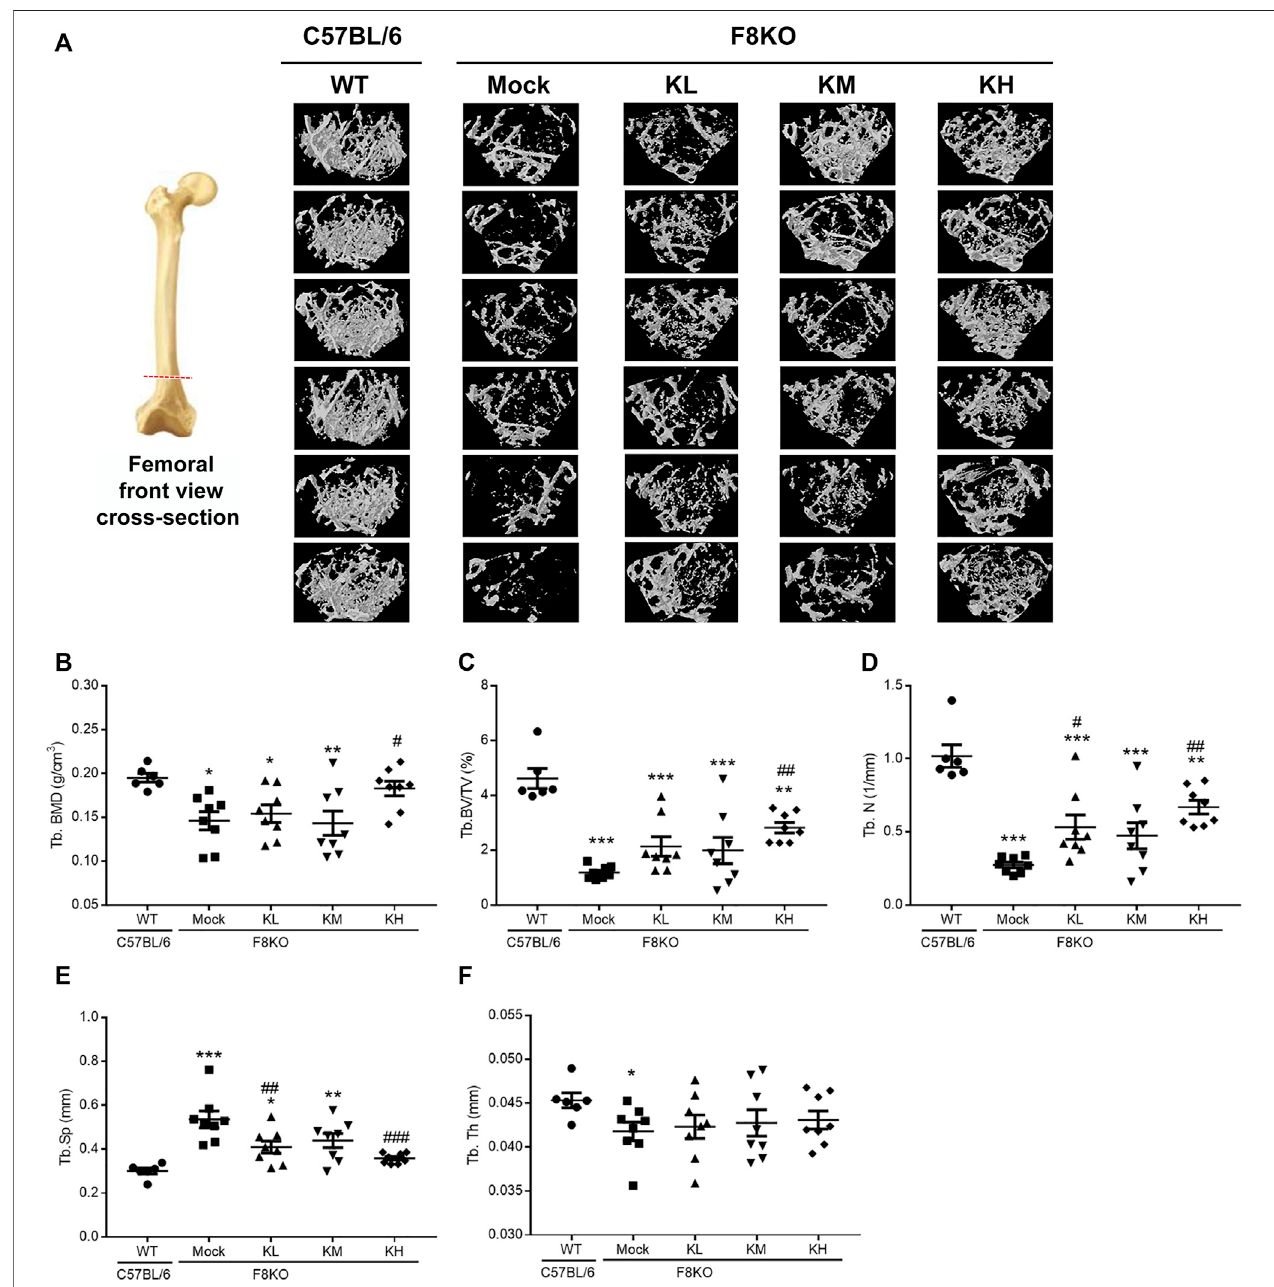
FIGURE3 | Effects ofKP treatment on femoral trabecular bone. F8KO mice at 20 weeks ofage were orally administered different dosages ofKPs for 8 weeks ( n = 8). At theend oftreatment,the mice weresacri fi ced and leftfemurbones wereanalyzed by μ -CT tocharacterize thechangesinbone microarchitectural parameters. (A) Representative trabecular morphological images of transverse-sectional distal femur bone. The quantitative μ -CT results for (B) Tb.BMD, (C) Tb.BV/TV, (D) Tb.N, (E) Tb.Sp, and (F) Tb.Th. * p < 0.05, ** p < 0.01, and *** p < 0.001 vs. WT group; # p < 0.05, ## p < 0.01, and ### p < 0.001 vs. mock group.